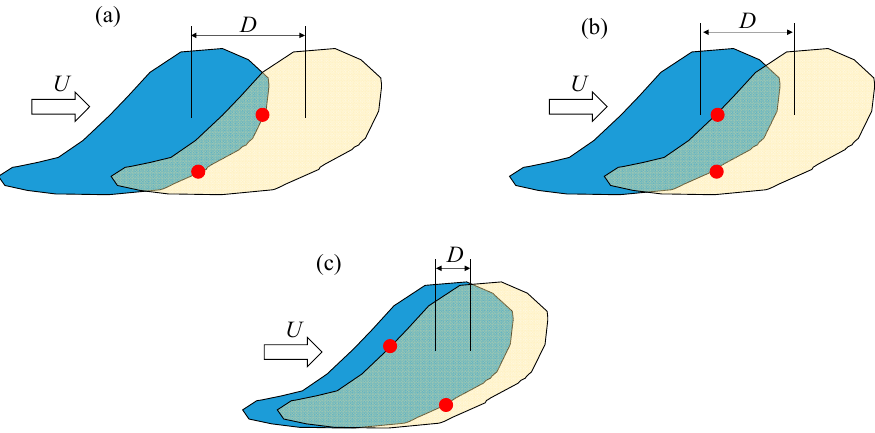
Figure 6. The explanation of the reducing wavelet coherent area and the increasing phase angle when the lower point moving from the upstream to downstream of the fixed upper point. When the lower point is located at the proper location of the upstream of the upper point, the two points almost enter the structure at the same time, as shown in ( a ). Thus, the typical signal of the hairpin packet presents at the same time in the velocity series in the two points and the phase difference is small, as shown in Figure 5 a . When the two points are on the vertical line as shown in ( b ), the lower point enters the structure after the upper one enters the structure for a while. There is hysteresis between the phases of the signal of the corresponding scale (see Figure 5b). As the lower point keeps on moving downstream, the phase difference will increase, as in ( c ).